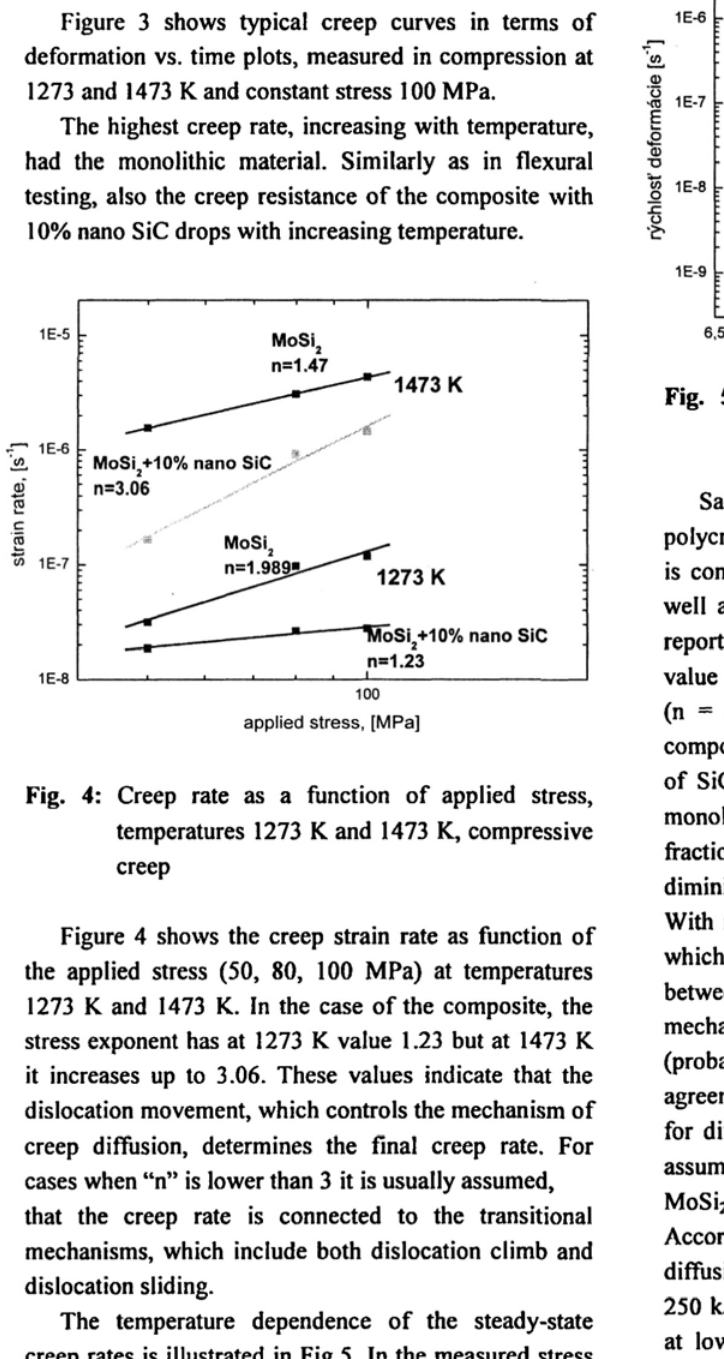
Fig. 5: Temperature dependence of the steady-state creep rates, compressive